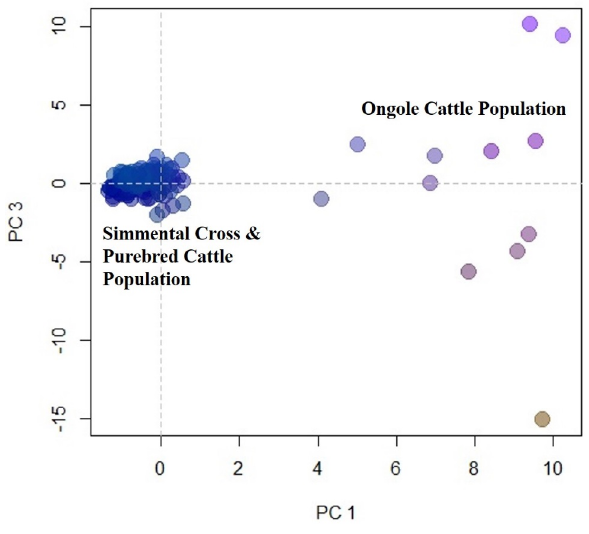
Figure 4. First and third components of a principle components analysis of 12-locus microsatellite genotypes from the Simmental Cross, the Simmental Purebred, and the Ongole